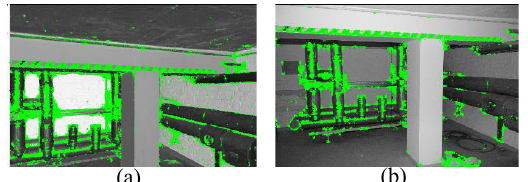
Figure 6. The ABrisk feature keypoints extracted from (a) synthetic image and (b) camera image.